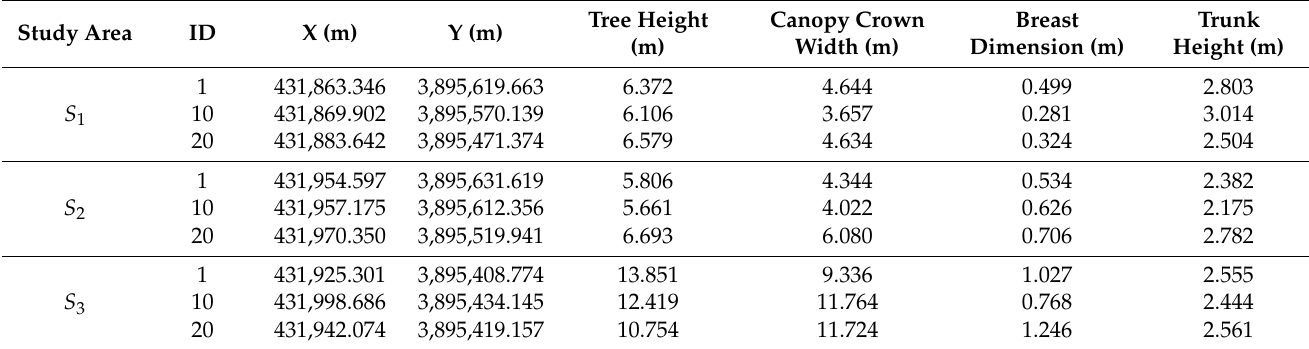
Table 6. Statistical table of geometric parameters of trees.